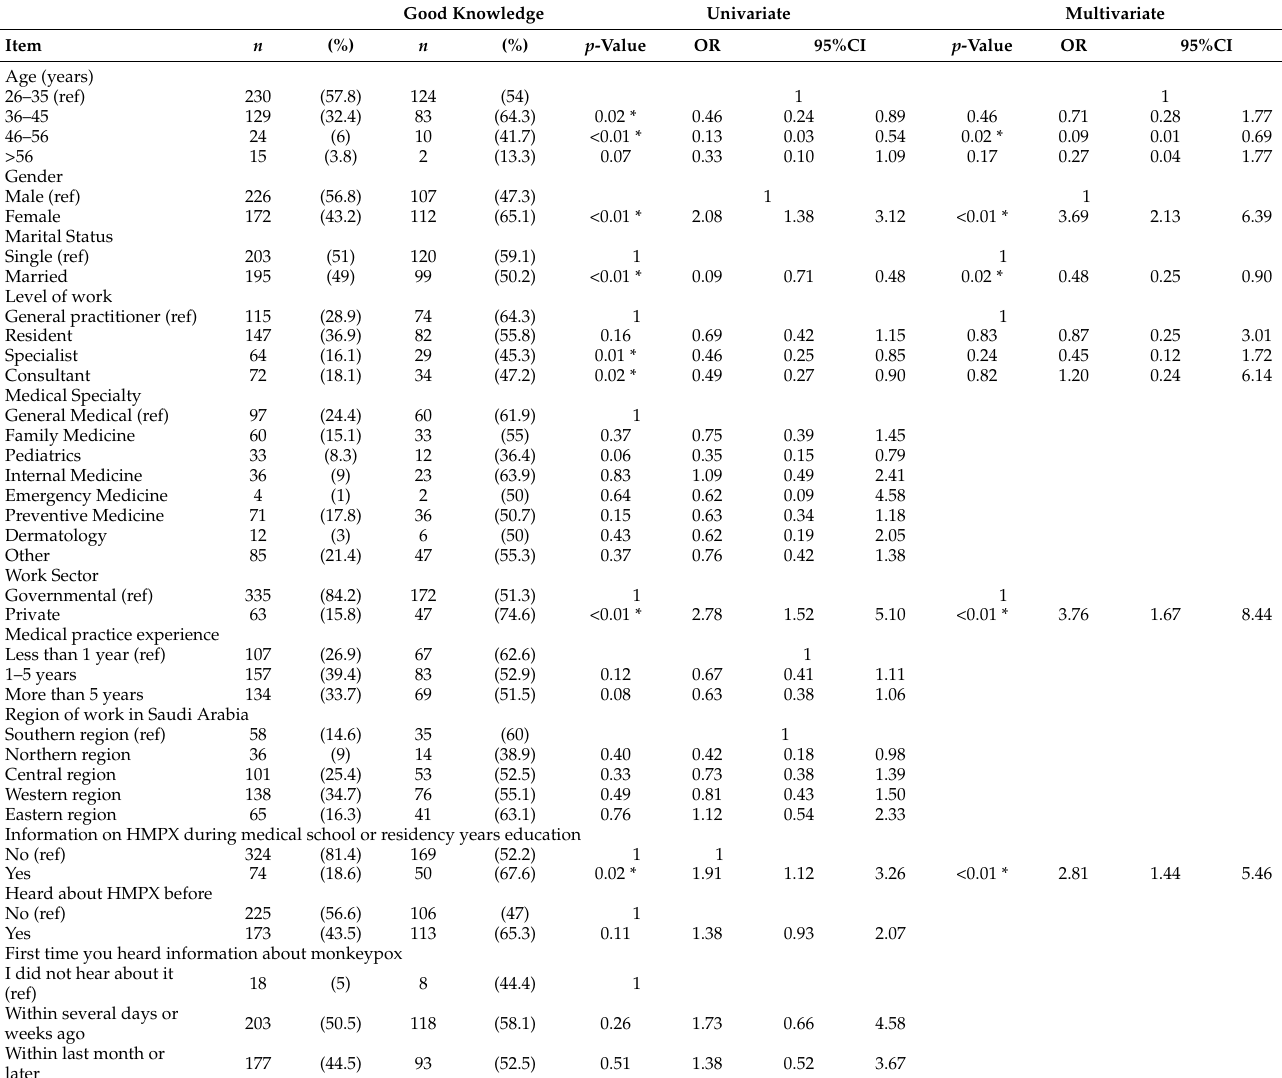
Table 4. Multivariable linear regression analysis for estimates of predictors associated with getting a good knowledge score about MPOXV among physicians who participated in the study ( n =